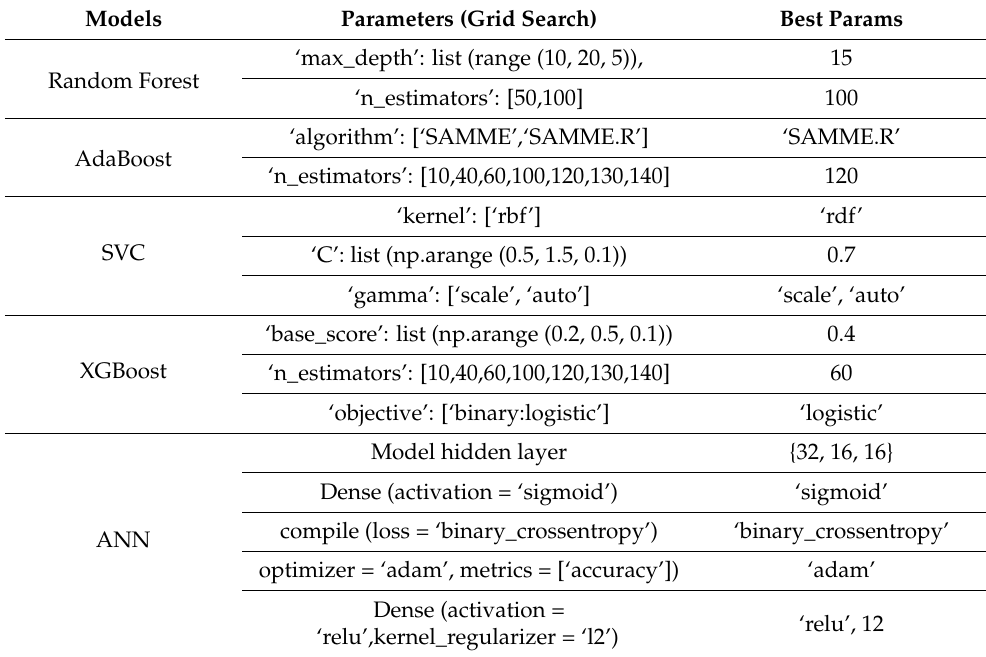
Table 4. Grid search results for the best combination of parameters.